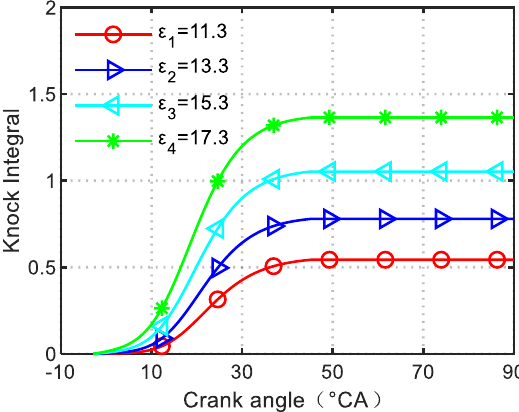
Figure 16. Knock integral under different compression ratio.